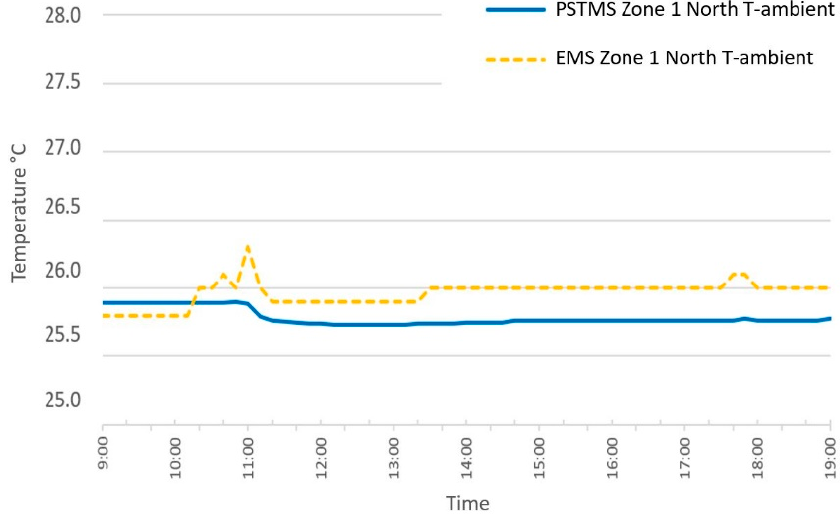
Figure 9. Air and surface temperature in Zone 2 for east and west orientation on 17/09/2019.